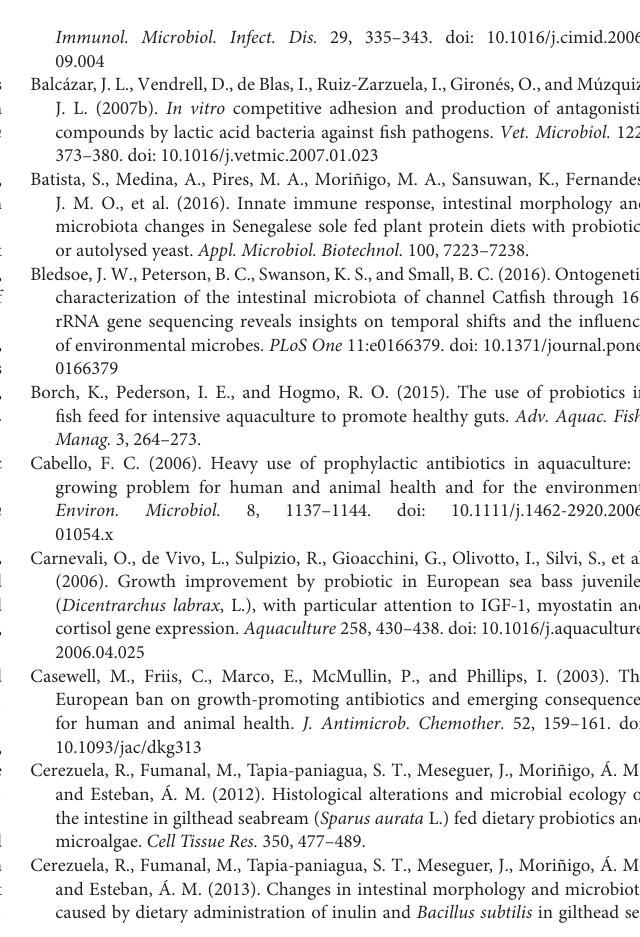
Supplementary Figure 3 | Validation plot of the PLS-DA model between control (Diet A) and experimental (Diets B and C) groups, consisting of 600 random permutations. Supplementary Table 1 | Primers for qPCR gene expression. Colors in letters of column Gene show different gene functions included in the array as follows: red: Epithelial integrity; dark blue: Nutrient transport; green: Mucus production; Orange: Cytokines; purple: Immunoglobulins; black: Cell markers and chemokines; light blue: Pattern recognition receptors. Supplementary Table 2 | Relative gene expression of anterior intestine in fish fed control (A) and experimental (B,C) diets. Data are the mean ± SEM of 9–12 fish. All data values were referred to the expression level of hes1-b of control fish with an arbitrary assigned value of 1. 1 P -value results from ANOVA. Bold font indicates statistically significant differences between groups ( P < 0.05). Supplementary Table 3 | Sequencing and taxonomy assignment results. Supplementary Table 4 | OTUs driving the separation between fish fed probiotic diets (B + C) and fish fed control diet A in the PLS-DA model (VIP >